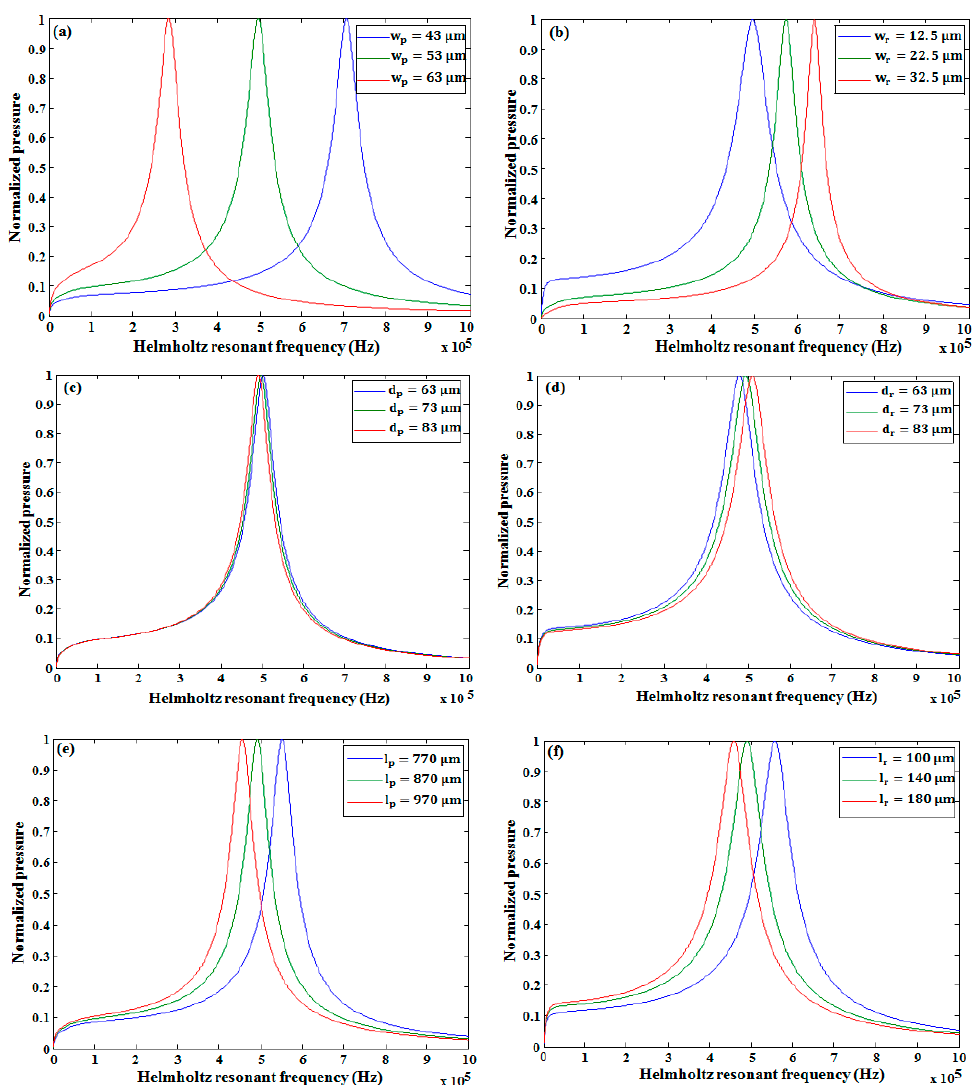
Figure 9. Change of the Helmholtz resonance frequency by varying the ( a ) pressure chamber width, ( b ) restrictor width, ( c ) pressure chamber depth, ( d ) restrictor depth, ( e ) pressure chamber length, and ( f ) restrictor length.